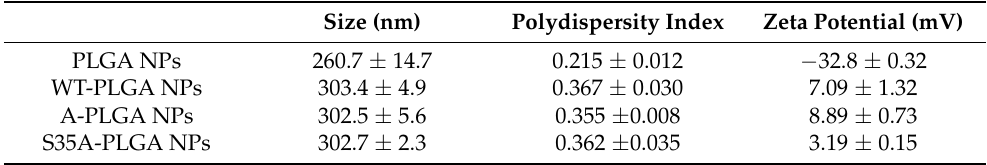
Table 1. Particle size, polydispersity index, and zeta potential of PLGA NPs, WT-PLGA NPs, A-PLGA NPs, and S35A-PLGA NPs in